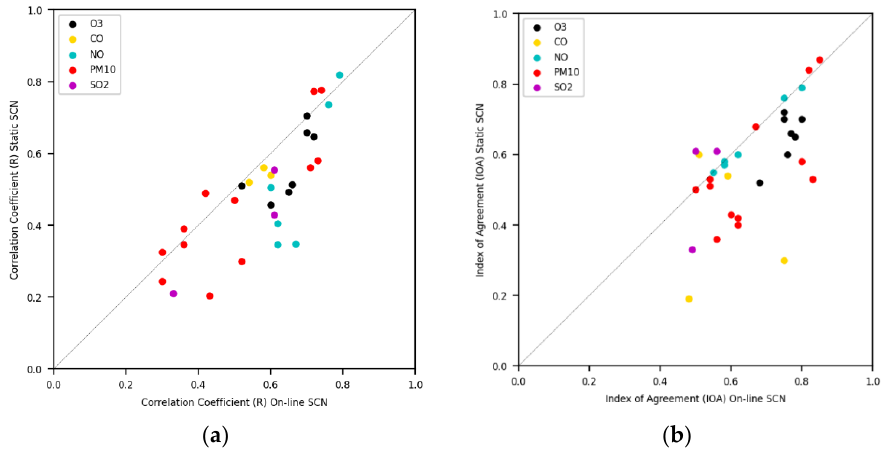
Figure 8. Comparison of the estimated ( a ) correlation coefficient (R) and ( b ) between on-line SCN and static SCN for O 3 , CO, NO, PM10 and SO 2 concentrations at the different monitoring sites studied for the cold period of 2015 (January–April, October–December).